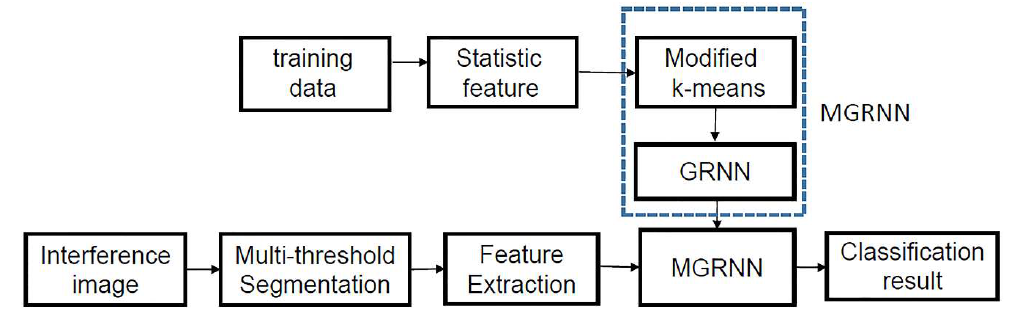
Figure 6. Frequency identification training and testing process of EMI sources.